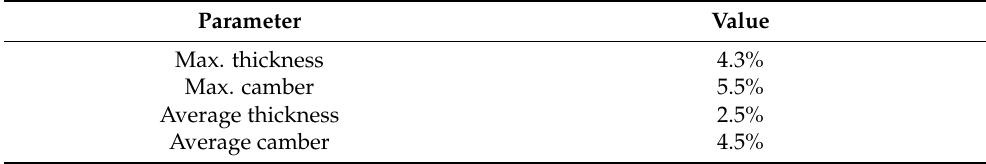
Table 1. Design parameters of the airfoil.